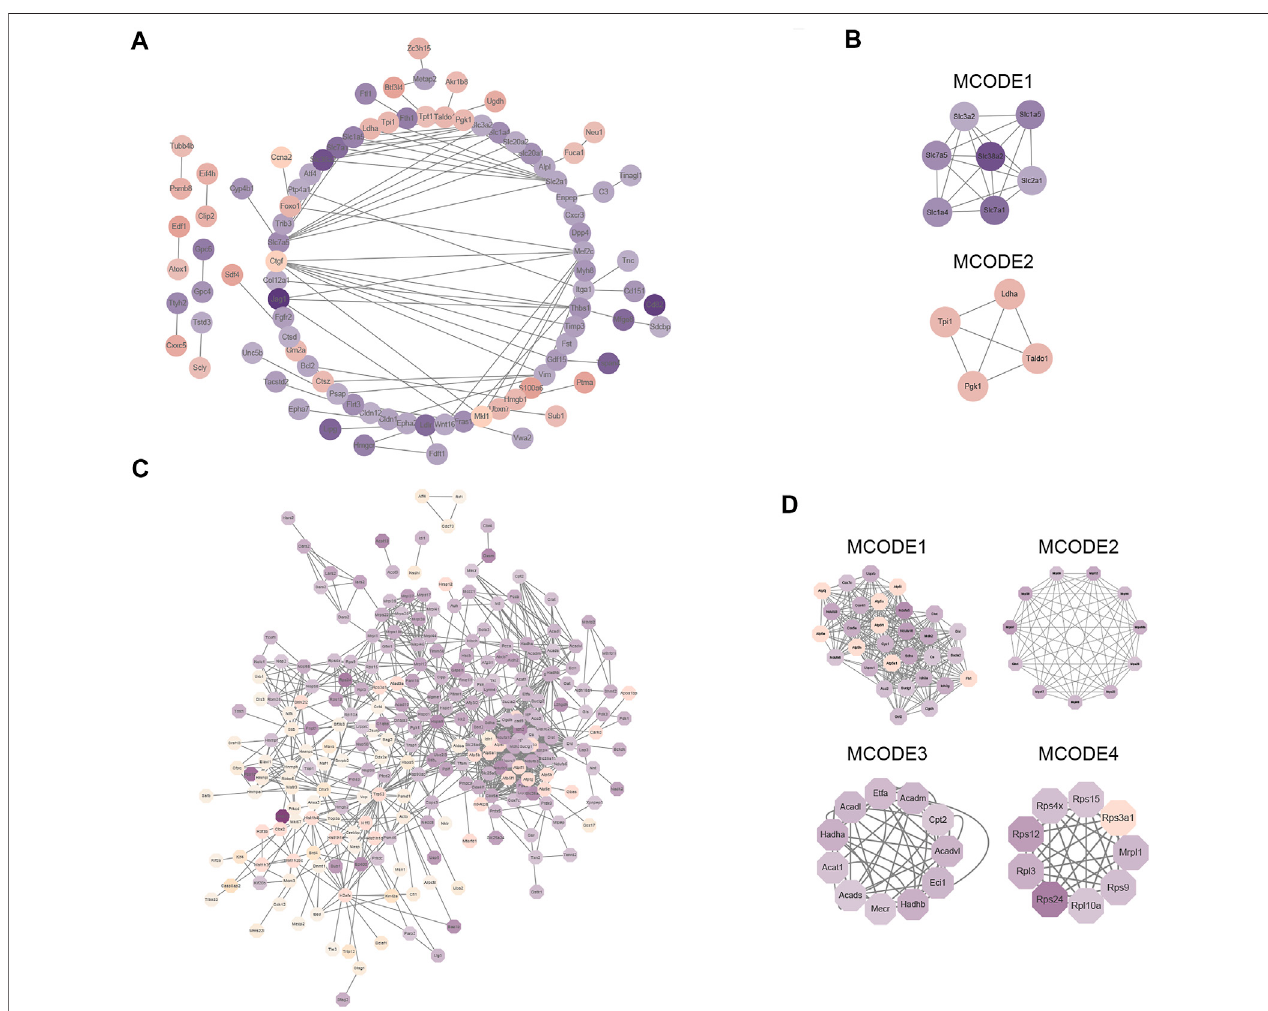
FIGURE 5 | Protein – protein interaction (PPI) network analysis of differentially expressed proteins in global proteome and acetylated proteome. (A) STRING and Cytoscapesoftware wereused tocreate aPPInetworkfortheglobalproteome. (B) Four modules ofthe global proteome. Thefour modules arebasedonthe Molecular Complex Detection (MCODE) algorithm; “ Degree Cutoff ” was set to “ 4 ” . (C) STRING and Cytoscape software were used to create a PPI network for the acetylated proteome. (D) Four modules of the acetylated proteome. The four modules are based on the Molecular Complex Detection (MCODE) algorithm; “ Degree Cutoff ” was set to “ 4.